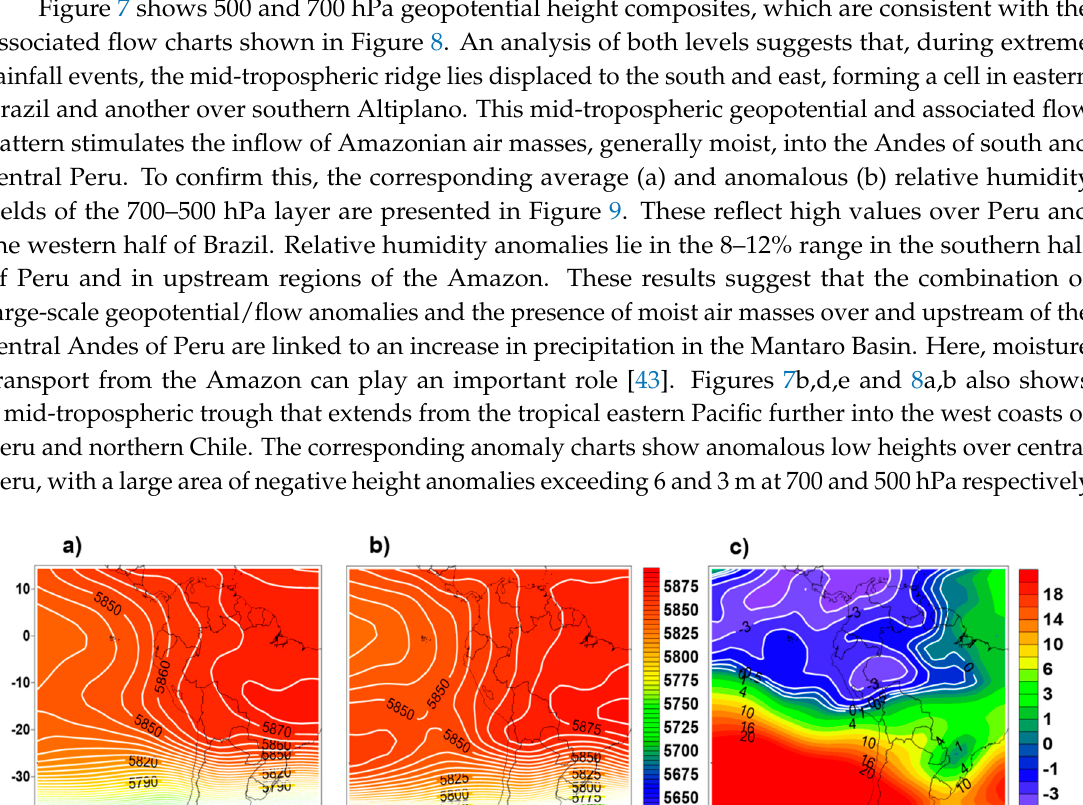
Figure 8. Composite wind fields averaged over the 40 extreme rainfall event cases for 700 hPa ( a ) and 500 hPa ( b ) in m s − 1 . Figure 9. 500–700 hPa layer relative humidity averaged over the rainy seasons of 1981–2017 ( a ); the